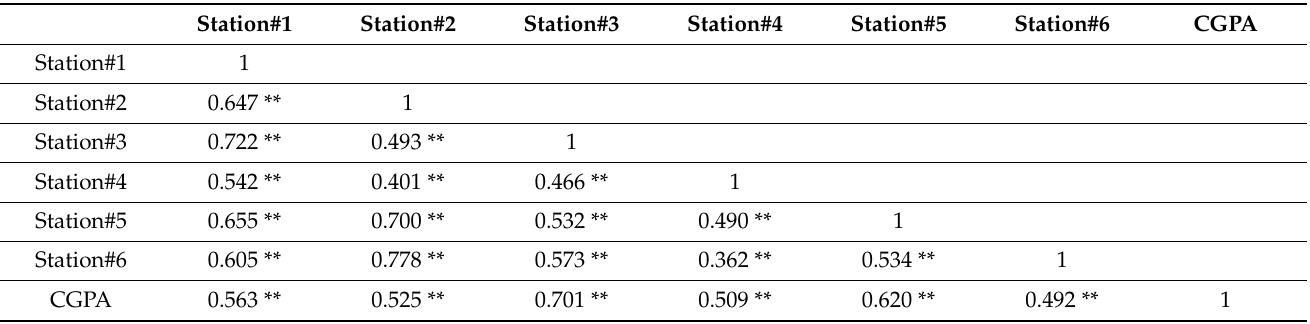
Table 4. Correlation matrix between OSCE station scores and